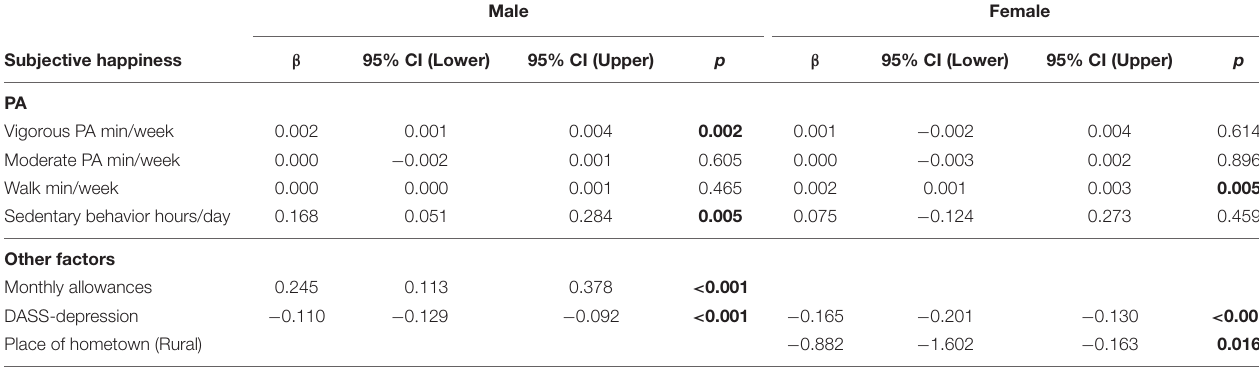
TABLE 3 | Association of subjective happiness and